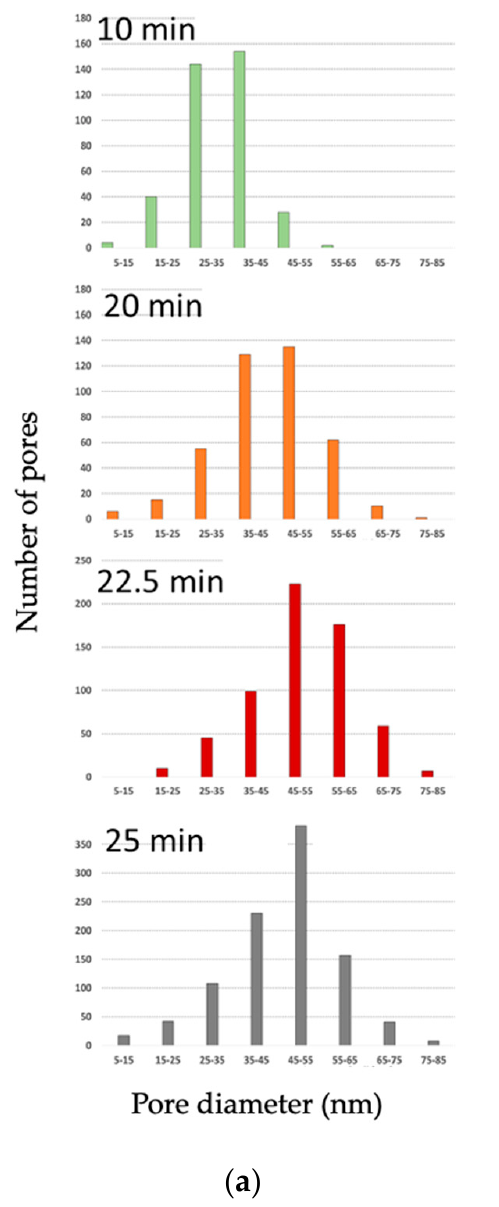
Figure 7. Pore size distribution analysis performed in ( a ) samples subject to diverse anodization times and ( b ) SEM cross–sectional image that illustrates pore length for the sample anodized 40 V, 1.6 M at 40 °C for 25 min.